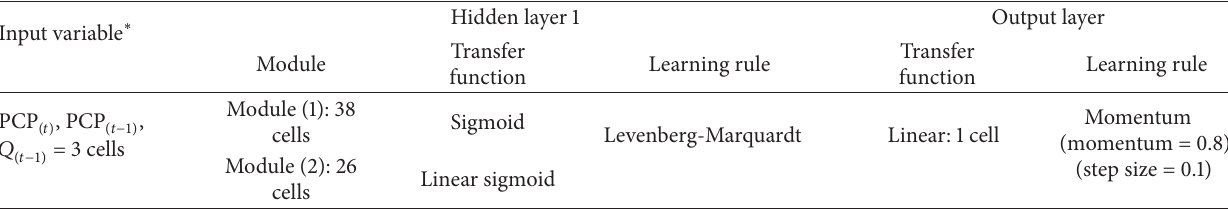
Table 4: Optimum architecture of FF-MNN in Roodan watershed.